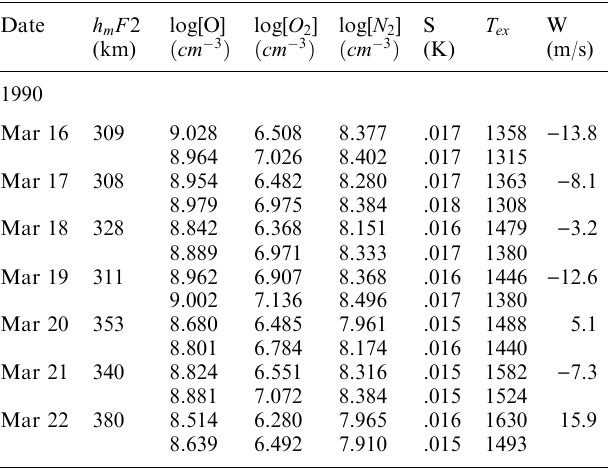
Table 2. Calculated thermospheric parameters and MSIS–83 model predictions (second line) at the height of h m F 2